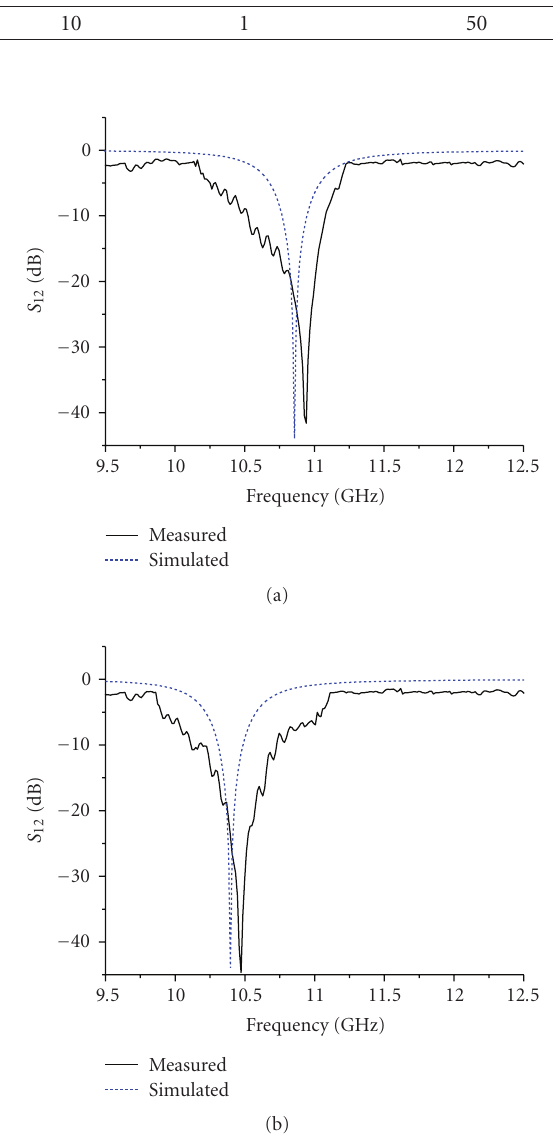
Figure 8: S 12 -parameter of the filter prototype with the single slot: (a) w = 1mm; (b) w = 2 mm.